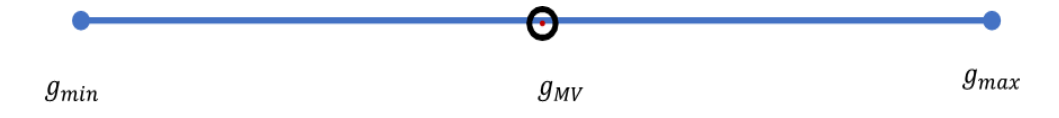
Figure 1. Distribution of policies demanded by voters.